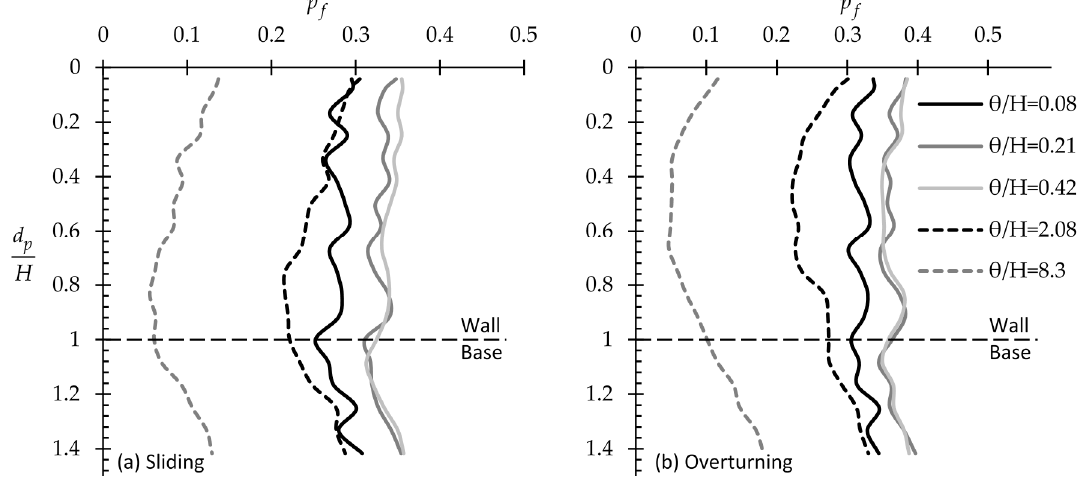
Figure 5. p f versus d p / H example curves for x / H = 0.5 and various θ / H values (perfectly rough wall) for the ( a ) sliding and ( b ) overturning mode of failure; to be compared with the case of perfectly smooth wall (Figure 4).